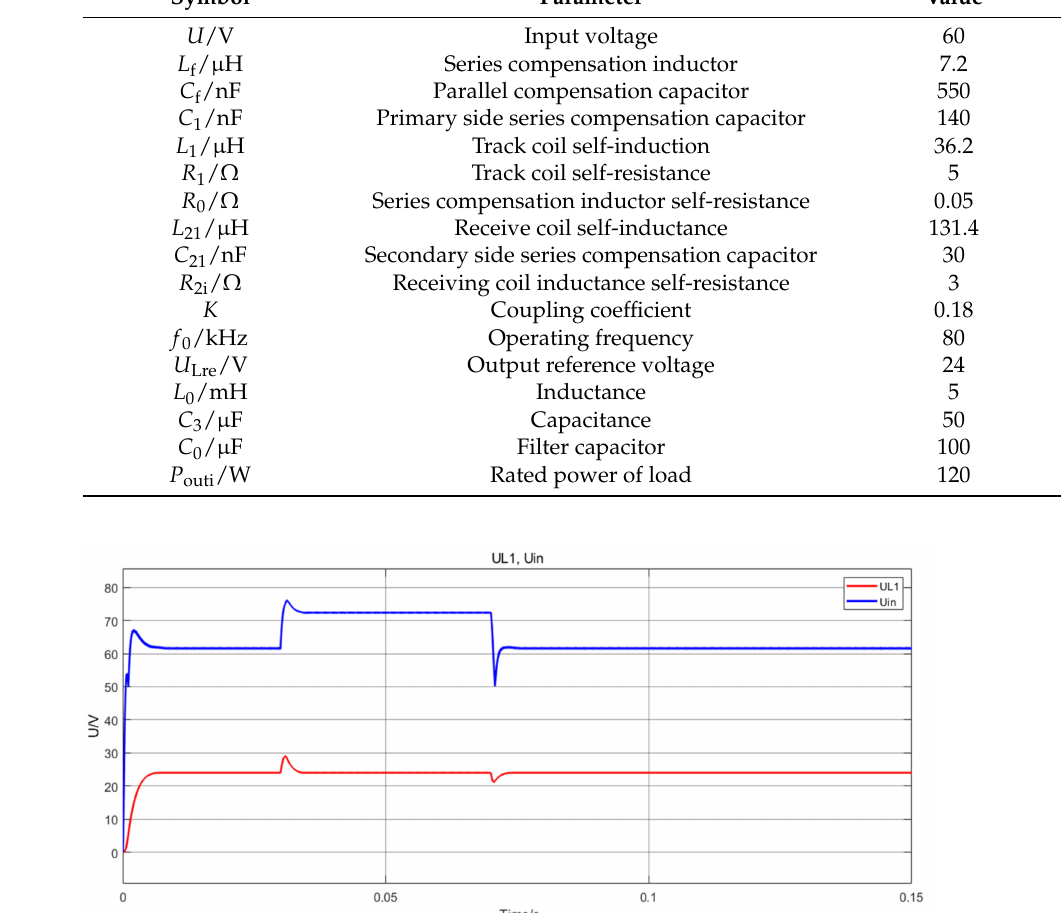
Figure 14. The output voltage of load #1 and the input voltage U in of Buck circuit.